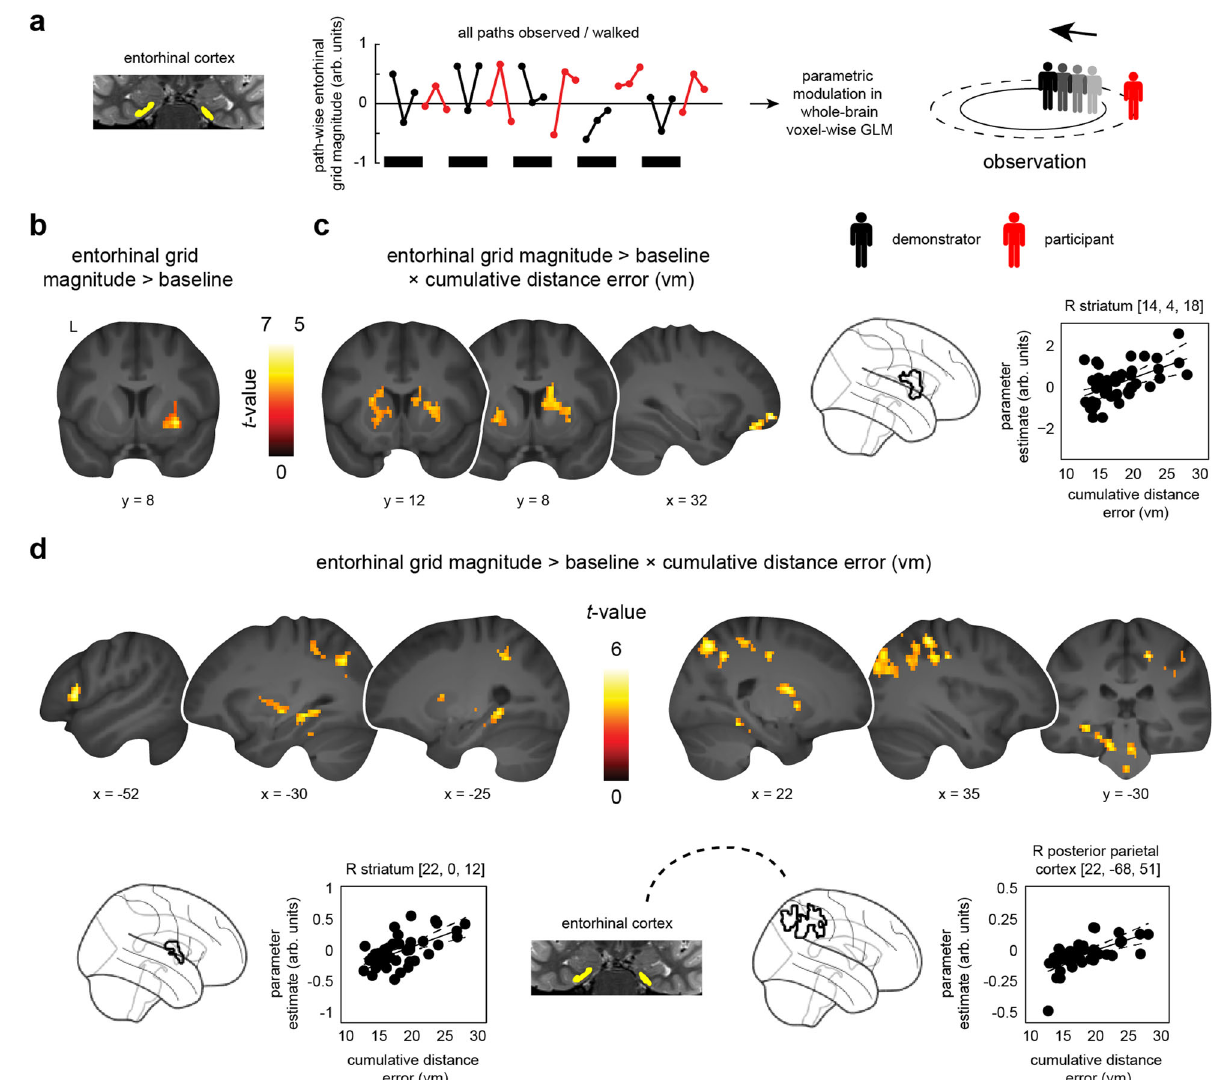
Fig. 4 | Brain activation pro fi les and connectivity changes time-locked to entorhinal grid-like codes during observation, and association with perfor- mance. a Grid orientations and magnitudes were estimated and tested on inde- pendentdatasets (GLM1and GLM2),focusing ondatawithinthe entorhinalcortex (yellow). This yielded participant- and path segment-speci fi c grid magnitudes for each of the 36 path segments per condition and task run. Observation periods are indicated in black (navigation periods in red, 1 example task run). Segment-wise grid magnitudes were then used to parametrically modulate observation/naviga- tion eventsina third, independentanalysis (GLM3) thattestedforvoxel-wise brain activation/connectivity changes time-locked to fl uctuations in entorhinal grid magnitude during observation. b Increased brain activation during observation periods (compared to the implicit baseline), positively scaling with entorhinal grid magnitudes (one-sample t -test, N =47). c Same contrastassociated withbehavioral time-locked to fl uctuations in entorhinal grid magnitude (i.e., stronger whenparticipantsobservedthedemonstratorwalkingalignedwiththeir individual entorhinal grid orientation) and larger the worse participants performed when re-tracing the demonstrator ’ s paths (linear regression, N =47, same participant sample as during initial grid analysis, contrast parametric modulation through entorhinal grid magnitude during observation > baseline, cumulative distance error across allpaths added as a covariate of interest; please note that we here deviated from our a priori cluster-de fi ning threshold of p <0.001, showing results that reachedsigni fi canceonlyat amore lenient statisticalthreshold, p <0.05 FWE-corrected at cluster level using a cluster-de fi ning threshold of